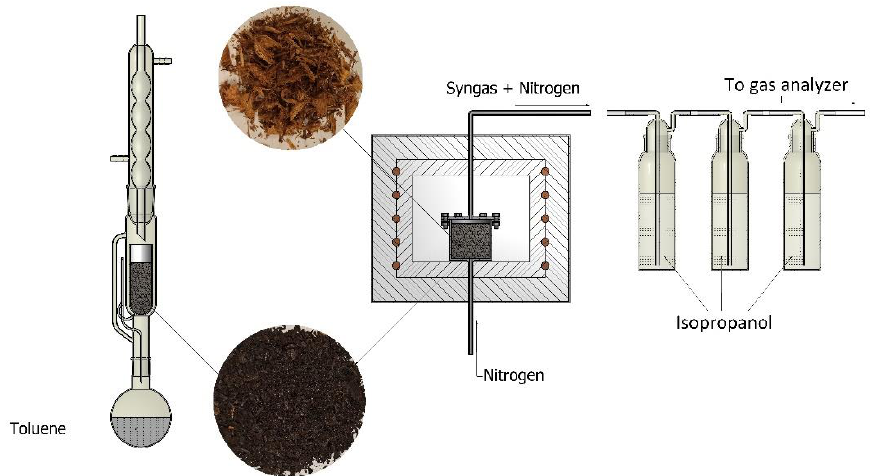
Figure 3. Scheme of the experimental setup for thermal neutralization of waste.